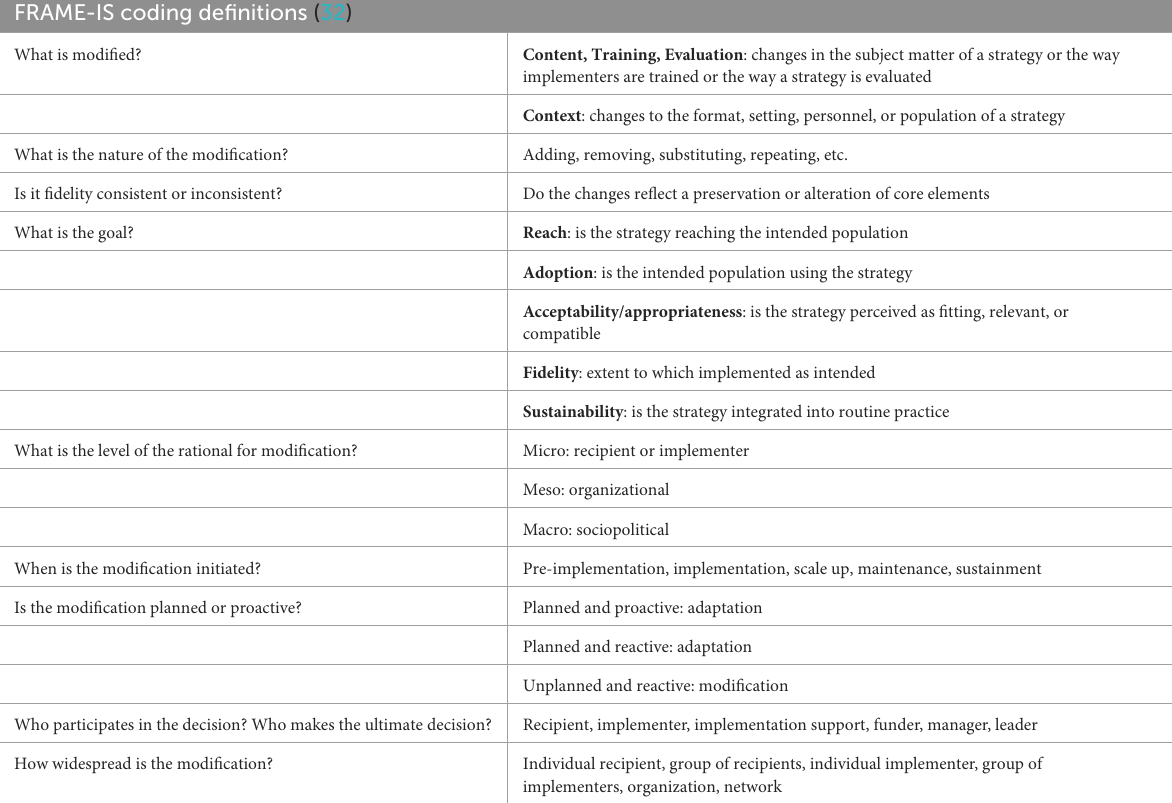
TABLE 1 Definitions of key implementation outcomes and modifications. FRAME-IS coding definitions